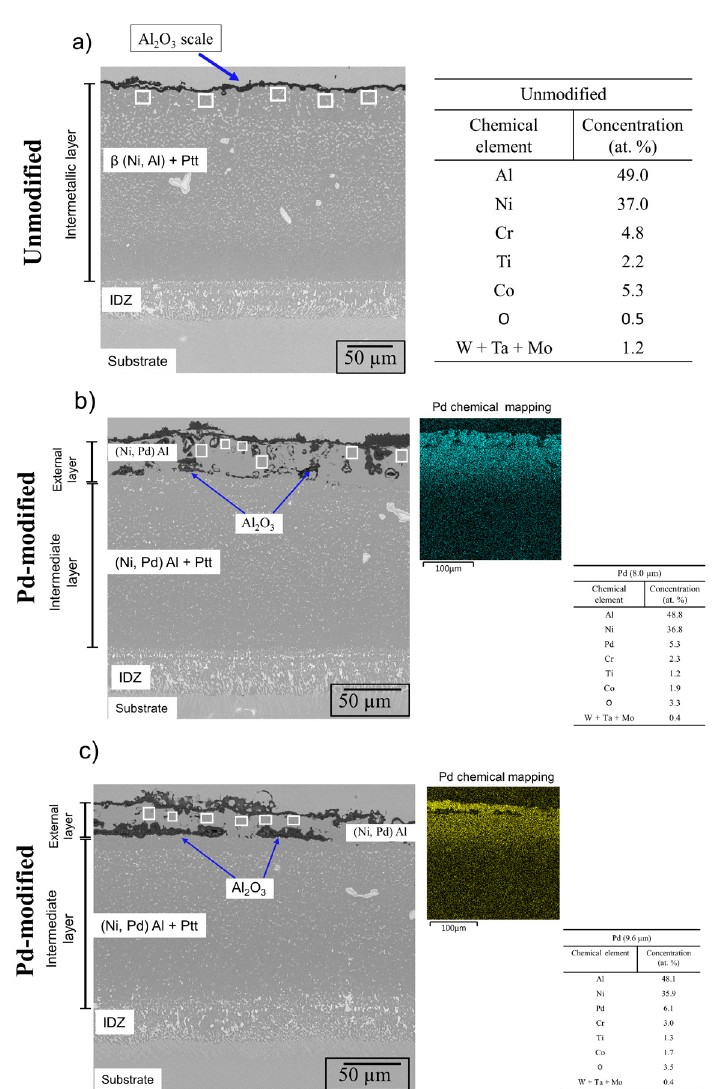
Figure 9. Average chemical composition (at. %) of aluminized coatings after isothermal oxidation at 1000 °C for 200 h: a) unmodified; b) Pd-modified (8.0 µm); Pd-modified (9.6 µm). The regions chosen for analysis are indicated by white